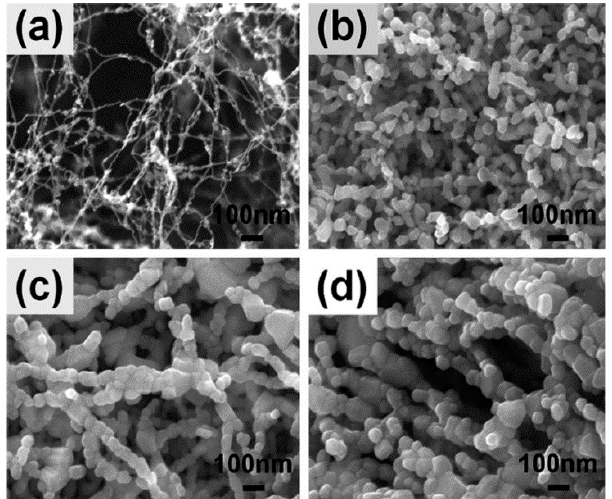
Figure 12. ( a ) The morphology of the SWCNT template. ( b – d ) WO 3 nanowire morphology for